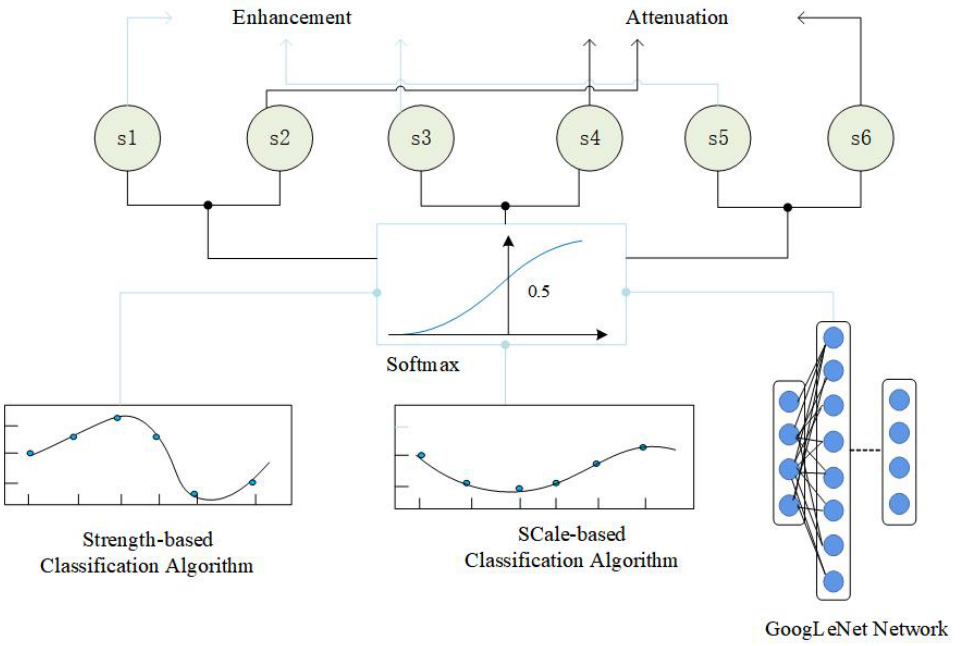
Figure 1. The proposed trend recognition method is composed of the strength-based algorithm, the scale-based algorithm, and the GoogLeNet network. Each of these three parts will be processed by the softmax classifier and give 2 scores. The scores then are used to recognize the enhancement and attenuation